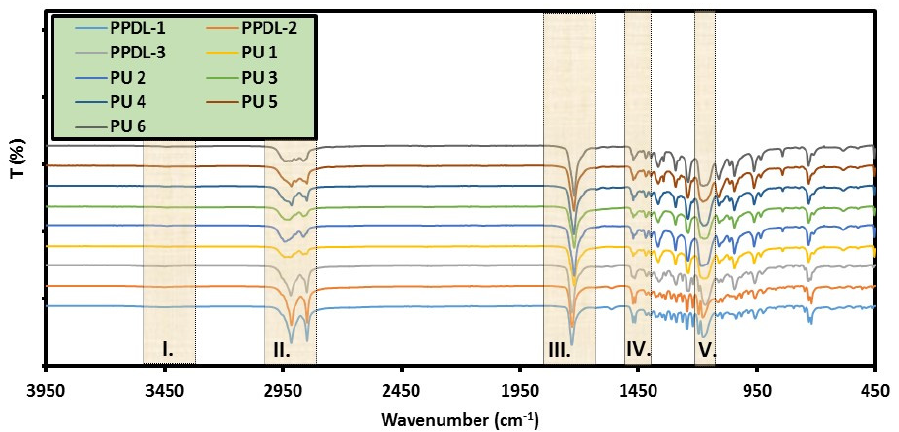
Figure 3. ATR-FTIR spectra of the synthesized PPDL and PU samples in the range of 450–3950 cm − 1 . The shaded areas represent the characteristic bands.